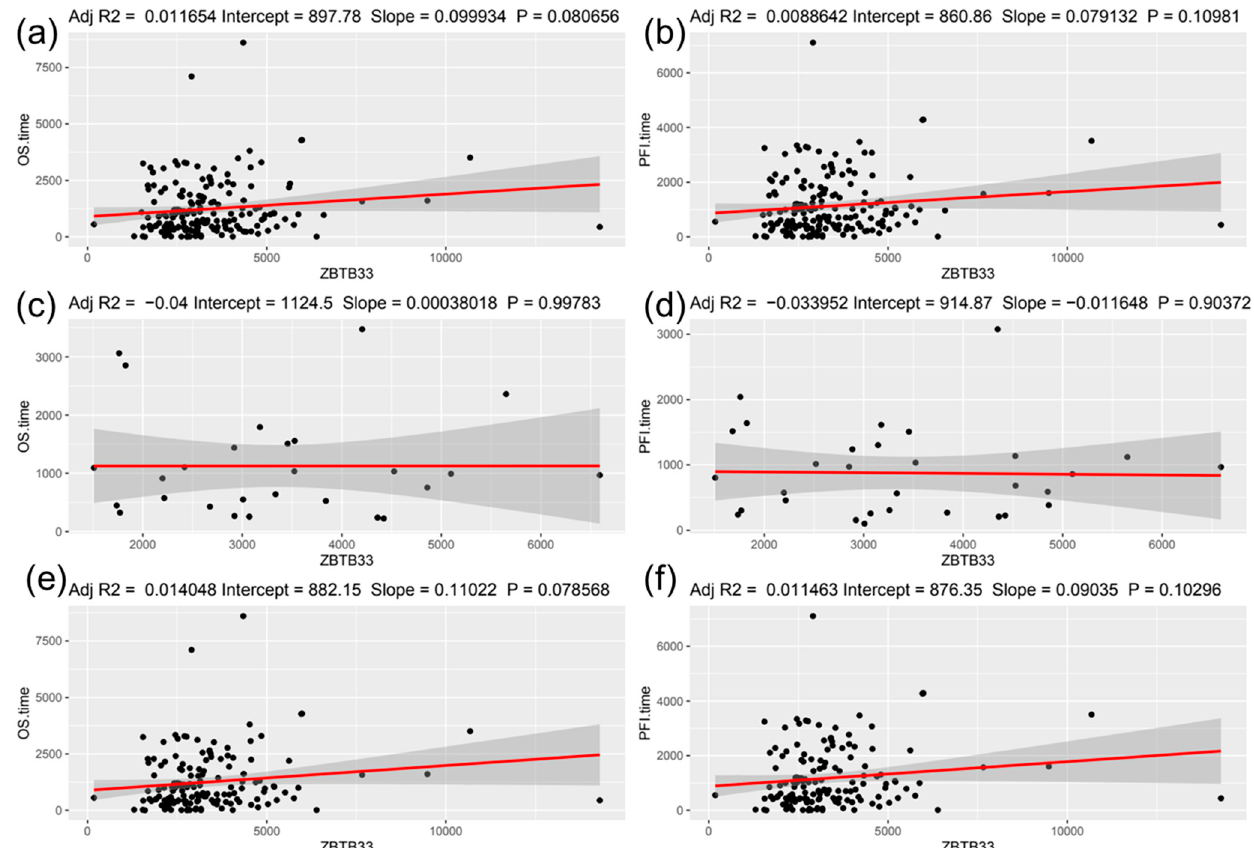
Figure 2. Scatter plots and linear regression lines of clinical data (OS and PFI) and ZBTB33 expression in RNAseq TNBCs TCGA cohort. ( a ) Overall survival (OS) for all patients, ( b ) progression-free interval (PFI) for patients who died from any cause, ( c ) OS for only event patients, ( d ) PFI for patients for dead patients or having new tumor event, ( e ) OS for the censored patient group, ( f ) PFI for the censored patient group.